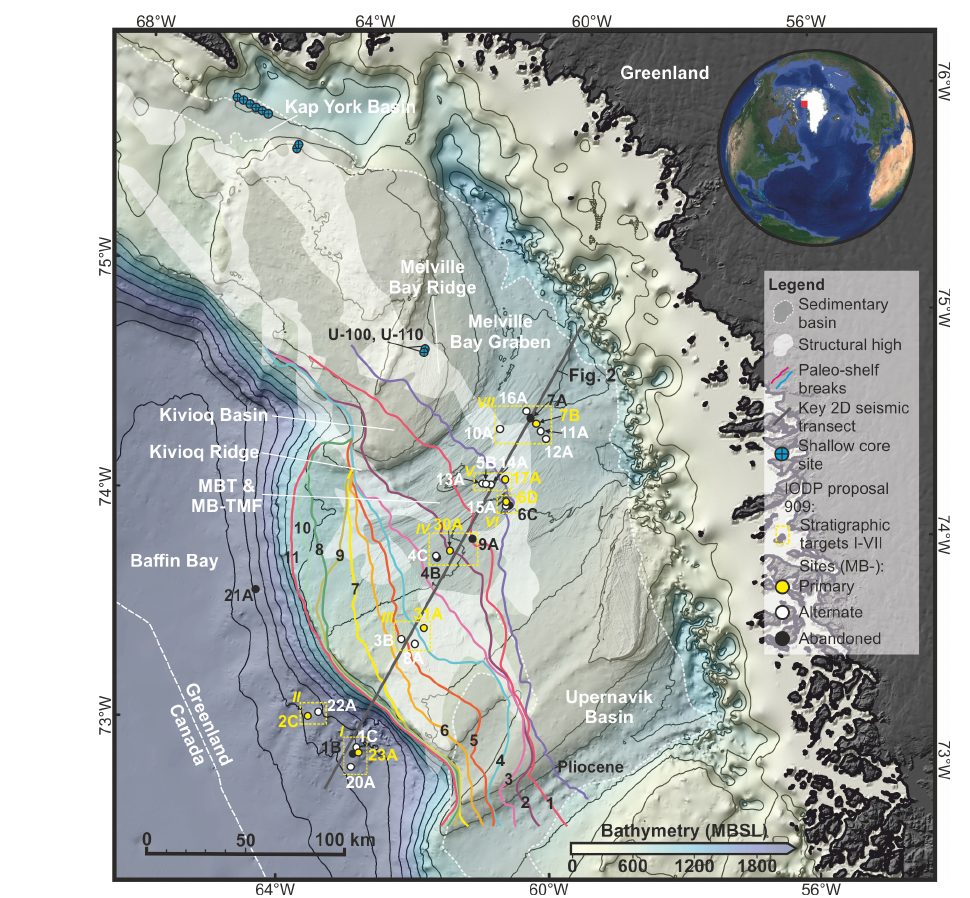
Figure 1. Location map. A bathymetric map of the Melville Bay area in north-western Greenland from Newton et al. (2017), showing the extensive influence of glaciation on the seabed including the Melville Bay Trough (MBT) and Melville Bay Trough Mouth Fan (MB-TMF). The red square on the inset map shows the global location of the bathymetry. Annotations on the map include the distribution of regional rift elements, including sedimentary basins and structural ridges, as well as the location of paleo-shelf break positions of glacigenic prograding units from Knutz et al. (2019). IODP Proposal 909 site locations are shown as well as the associated stratigraphic targets of each site (I–VII). Shallow cores that were drilled by a consortium led by Shell that provide stratigraphic information used within the proposal are also shown (Acton, 2012; Nøhr-Hansen et al., 2018). The location of the key regional 2D seismic transect used for original site selection is also shown and represents the location of Fig.